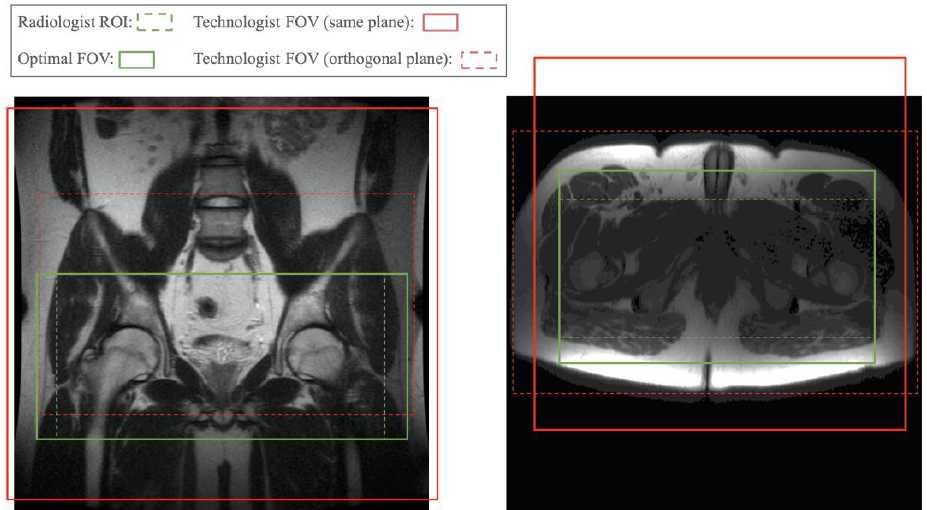
Figure 1. Technologist-prescribed FOV, and slice range for the orthogonal plane, compared with optimal FOV derived from radiologist’s ROI. Red solid boxes represent the FOV prescribed for the same plane as the localizer image. Red dashed boxes indicate the slice range and left–right FOV prescribed for the plane orthogonal to that of the localizer image, i.e., axial plane for the coronal localizer and vice versa. The red dashed box in the left sample truncated the bottom part of the ROI. The other three red boxes are much larger than needed.